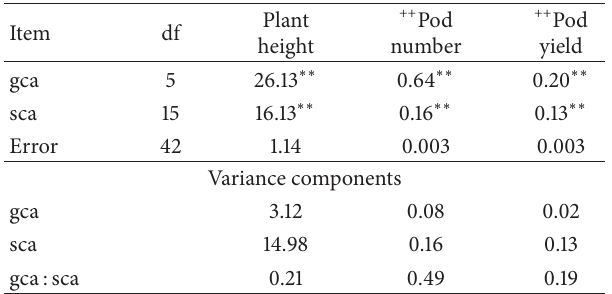
Table 5: Analysis of variance for combining ability of pod yield and related traits in a 6 × 6 F 1 diallel population subject to salt stress.